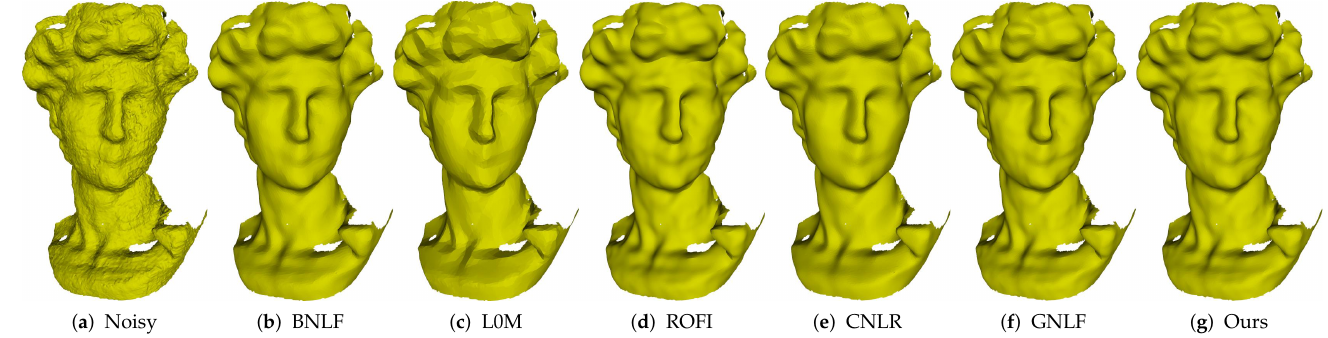
Figure 8. Denoising results of David scanned by